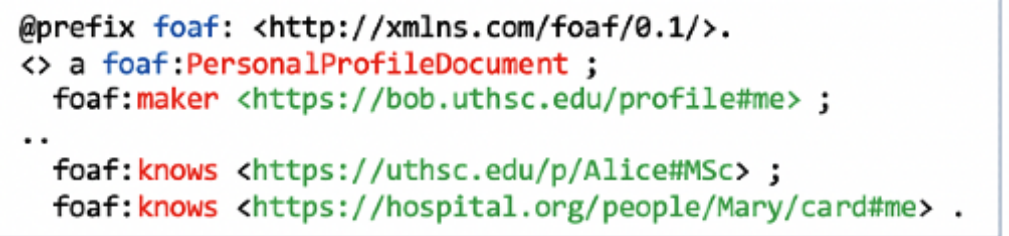
Figure 4. Bob’s extended profile document (friends) that identifies Alice and Mary as trusted agents by establishing foaf:knows relations with their WebIDs.